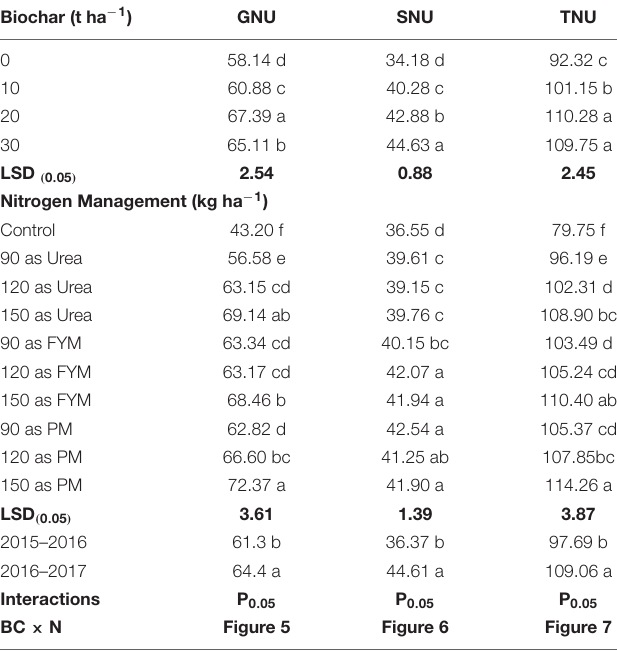
TABLE 3 | Grain, straw, and total nitrogen uptake (kg ha − 1 ) in wheat as affected by biochar and nitrogen application from different sources. Biochar (t ha − 1